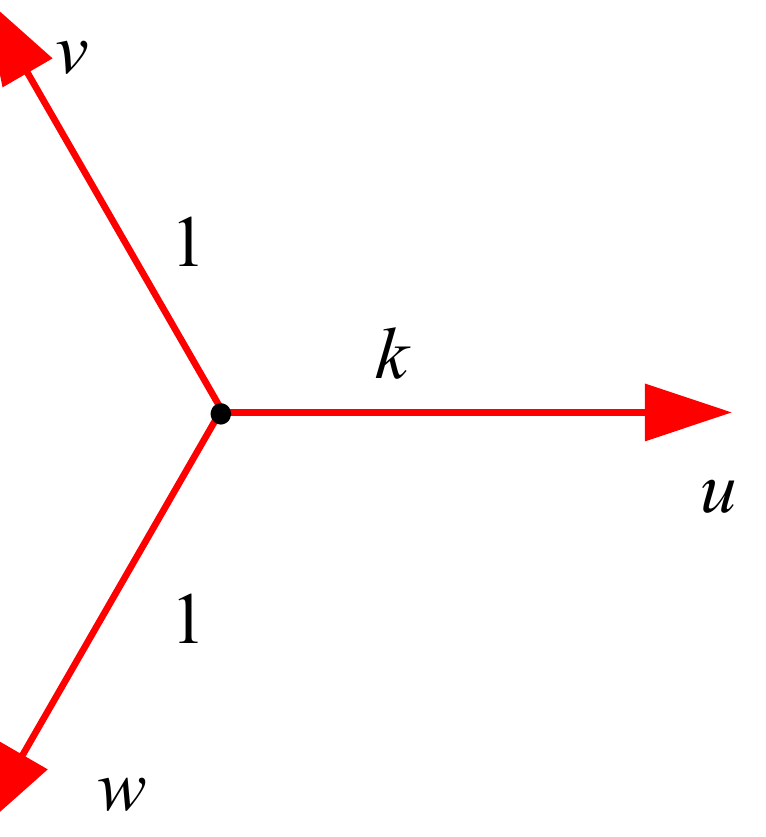
Figure 4. Standardized reference coordinate system with phase u